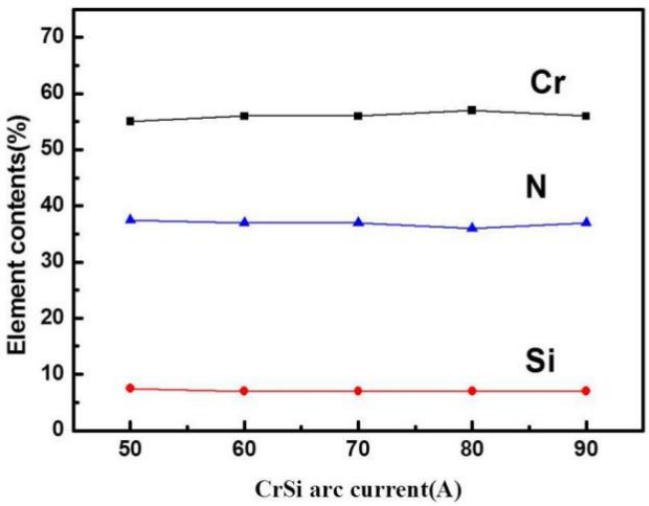
Figure 1. Elemental content of CrSiN coatings deposited under different CrSi arc currents.